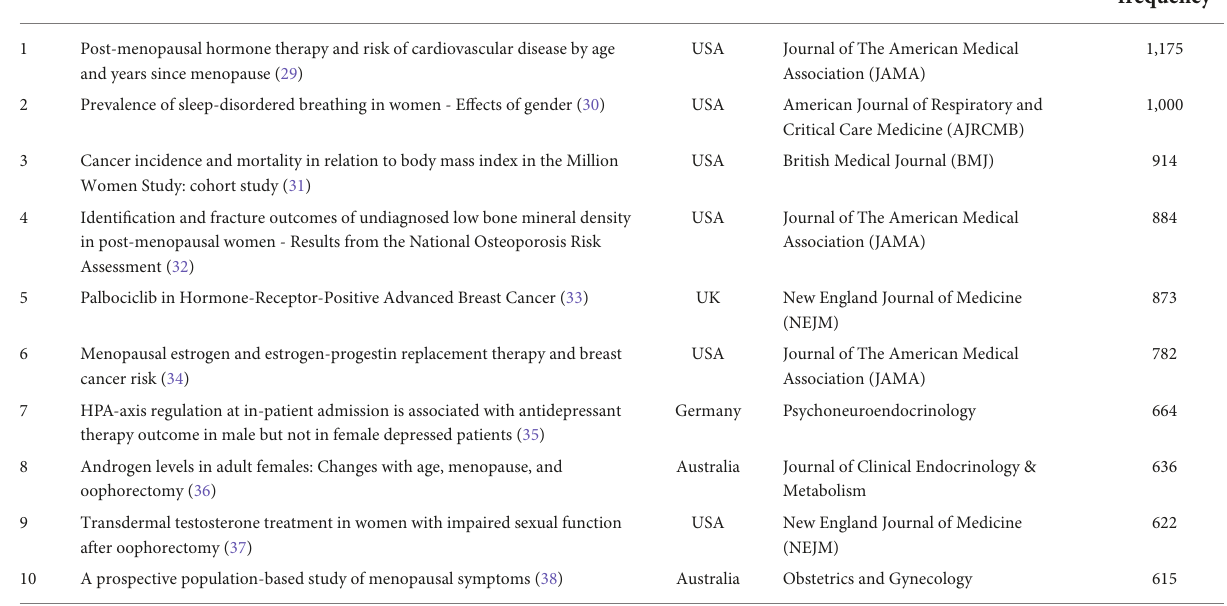
TABLE 5 The top-10 most-cited